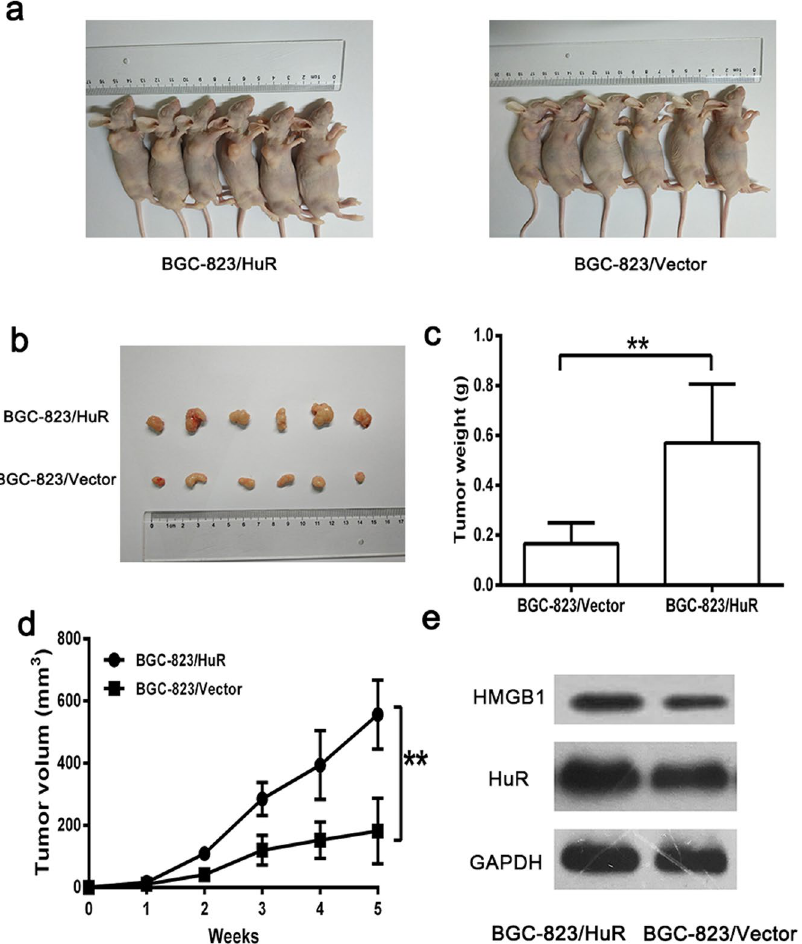
Figure 4. Overexpression of HuR promoted GC cell growth in vivo . ( a , b ) Representative images of tumors in the two groups after 5 weeks of growth. ( c , d ) The tumor volume and weight in BGC-823/HuR group was higher than that in the BGC-823/vector group. ( e ) Elevated expression of HuR and HMGB1 in the subcutaneous tumors was examined by western blotting. The data were represented as the mean ± SD, ** p <